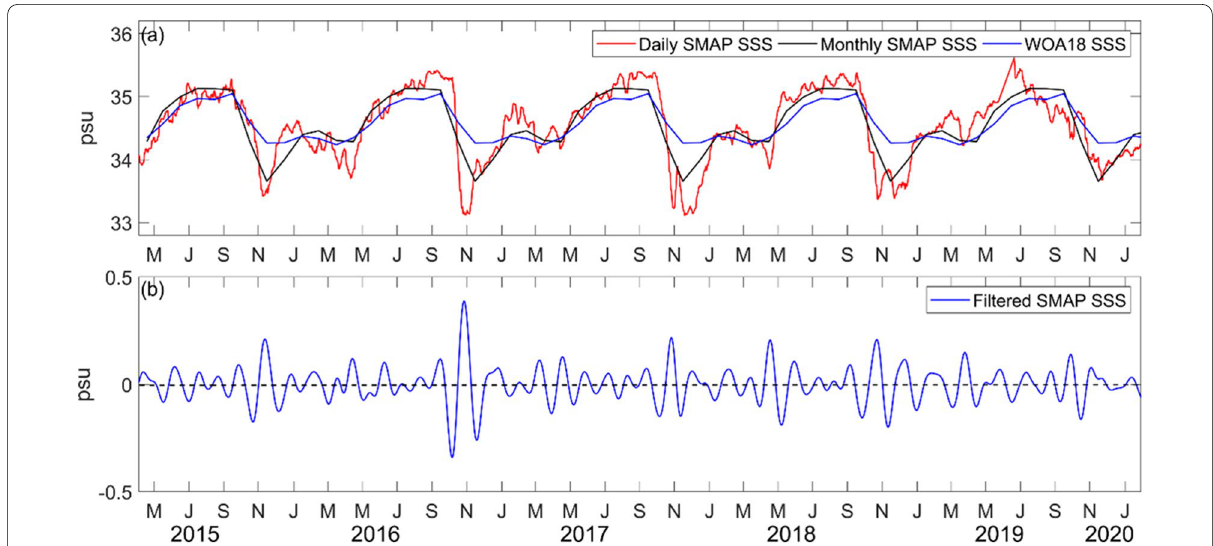
Fig. 3 Time series of regional mean SSS in the region south of the Indian Peninsula (74–82° E, 3–8° N). a Red curve is daily SMAP SSS, the black curve is monthly SMAP SSS, and the blue curve is climatology WOA18 SSS ( b ). The blue curve is filtered (30 ~ 60 days) SMAP